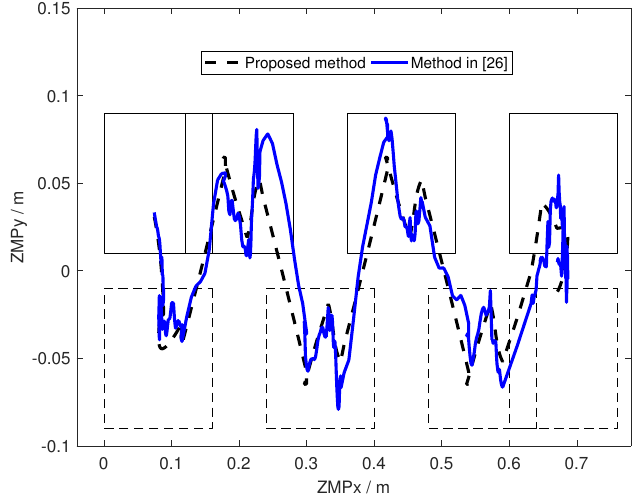
Figure 6. ZMP trajectories for BRZ-4 with two methods.